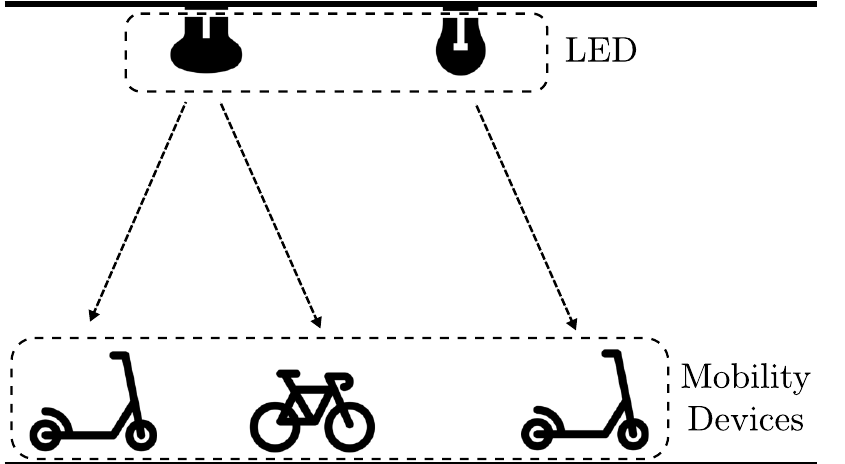
Figure 1. A general example scenario of Visible Light Communication applications for mobility services in indoor environments. The bicycle and scooters are driving or paused in the building or tunnel in this scene. Note that the line of sight between LED and mobility devices is available with multiple reflections. (Scooter icon in Vehicle and Travel Pack designed by Wishforge Games, www.wishforge.games), accessed on 3 January